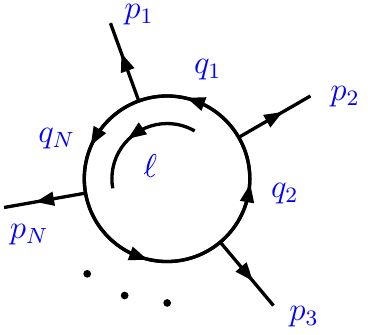
Fig. 1 Momentum configuration of the one-loop N -point